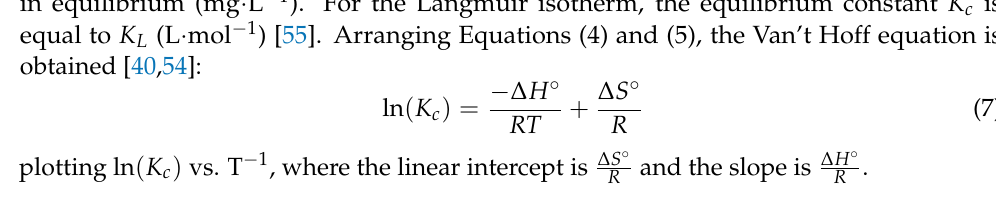
Table 6. Adsorption models of homogeneous and heterogenous monolayers